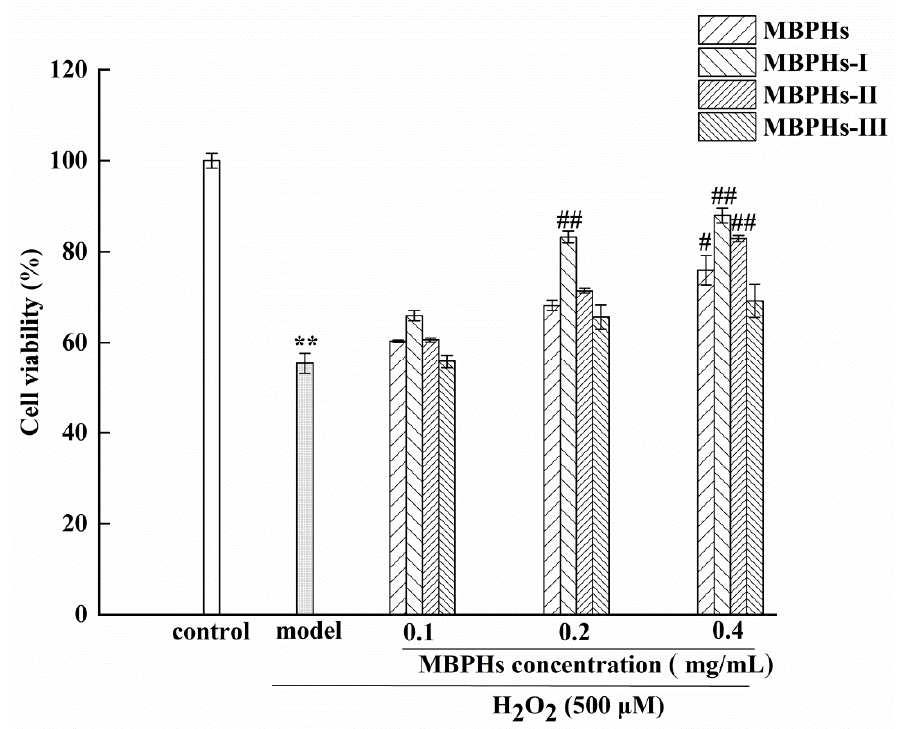
Figure 3. Cytoprotective effects of MBPHs, MBPHs-I, MBPHs-II, and MBPHs-II on H 2 O 2 -induced oxidized NCTC-1469 cells. Results are expressed as means ± SD ( n = 6), ** p < 0.01 vs. control group, # p < 0.05 vs. model group, ## p < 0.01 vs. model group.